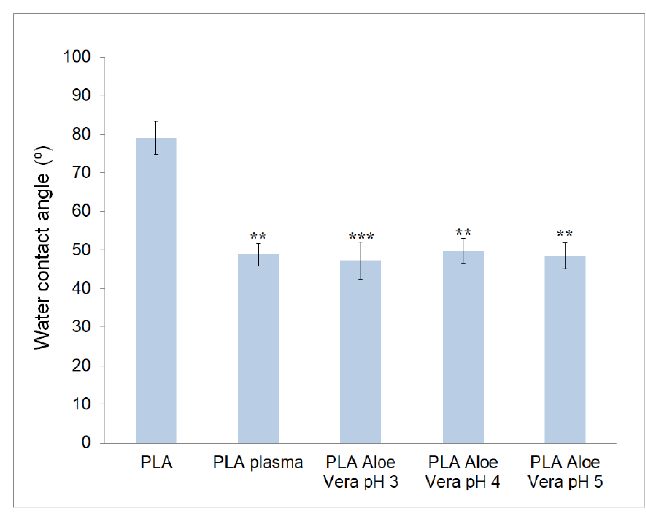
Figure 1. Water contact angle values for the non-treated, plasma-treated and coated samples obtained by compression molding (**p < 0.01 and ***p < 0.001), compared to the group of non-treated polylactic acid (PLA) samples.